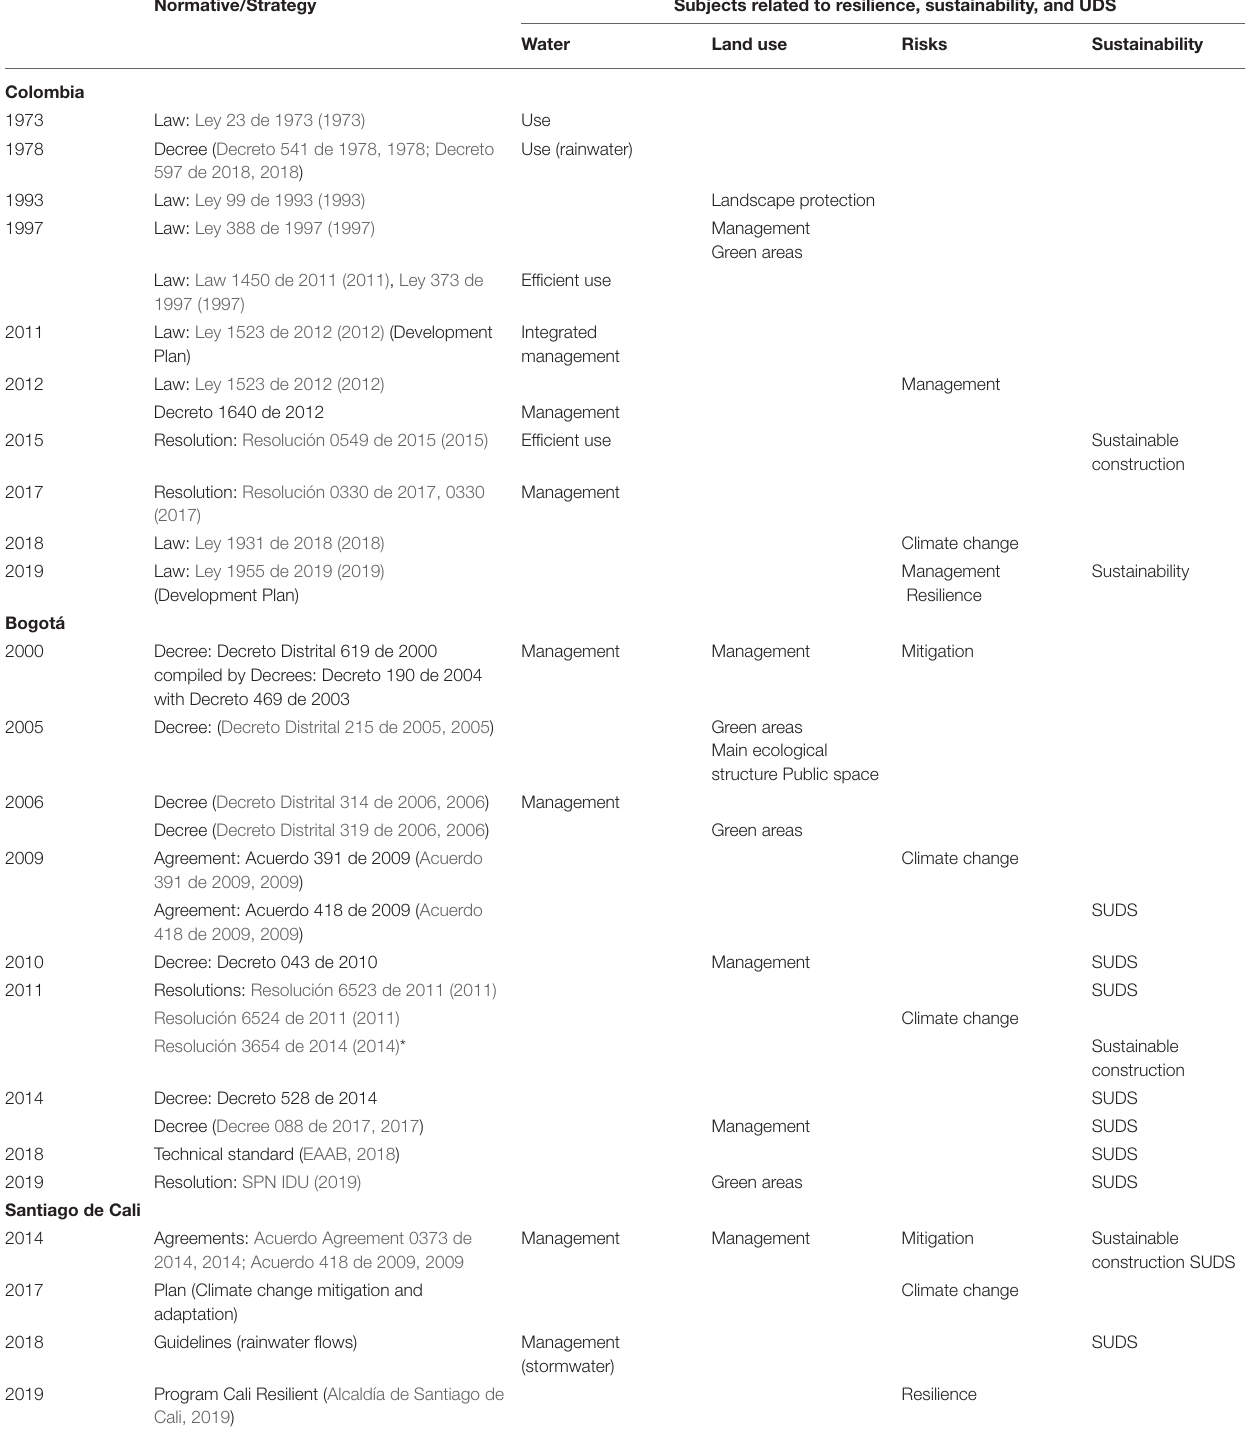
TABLE 2 | Regulations and strategies related to resilience, sustainability, and UDS.